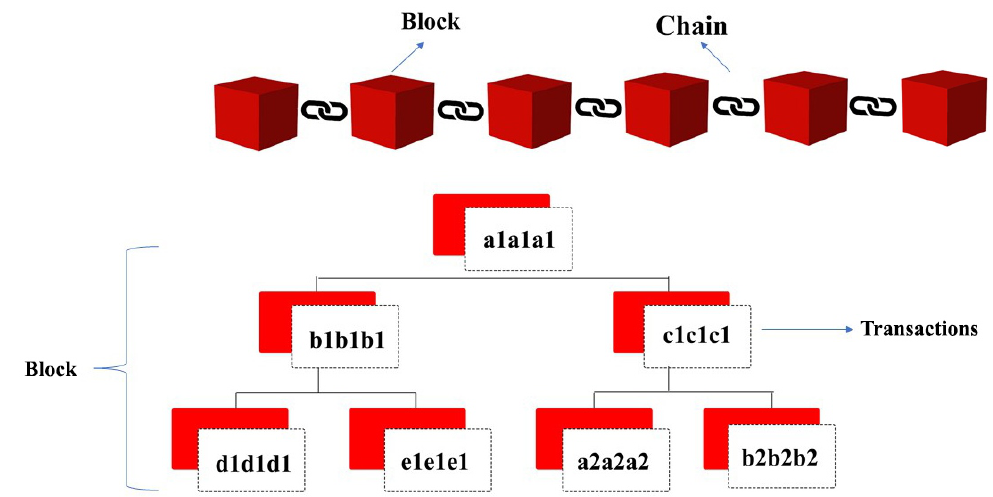
Figure 5. Relationship between transactions and blocks in Blockchain.